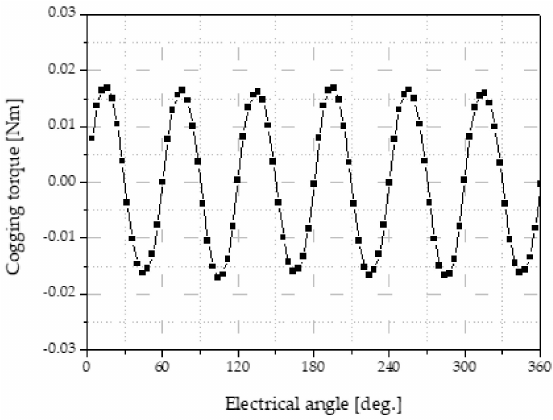
Figure 4. Cogging torque of basic spoke type IPM model.